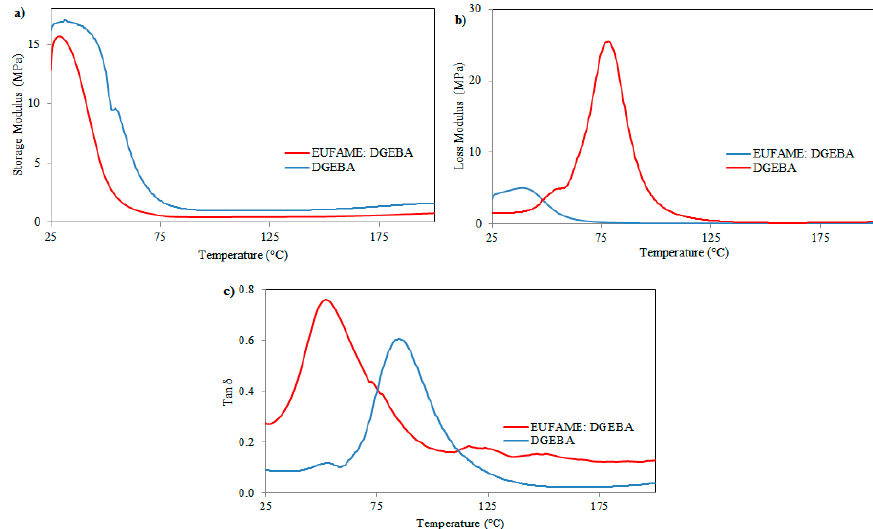
Figure 8. Variation in temperature of ( a ), storage modulus ( b ), loss modulus and ( c ) loss tangent (tan δ ) of cured neat epoxy resin (DGEBA) and cured EUFAME/DGEBA blend. Table 6. DMA values for cured neat epoxy resin (DGEBA) and cured EUFAME/DGEBA blend.